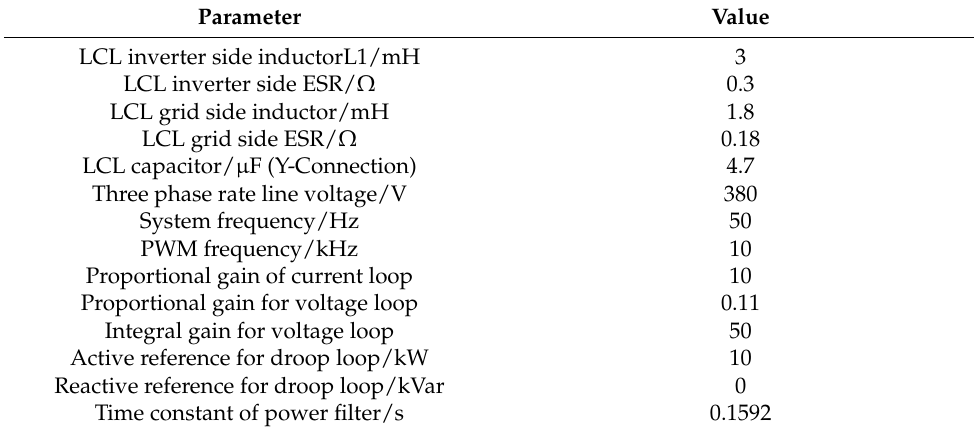
Table 4. Inverter